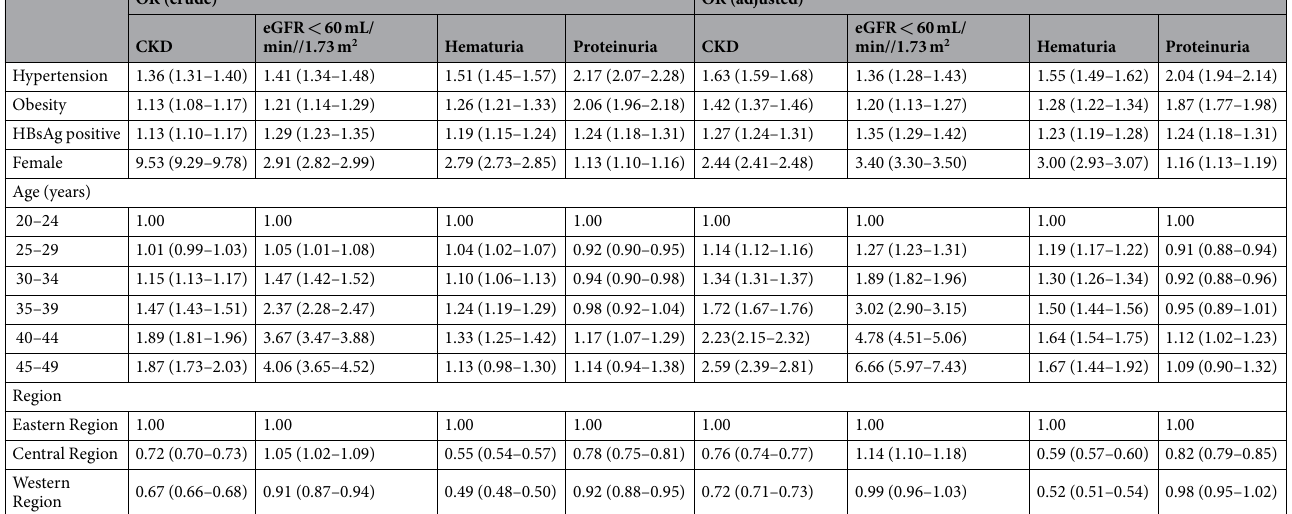
Table 5. Risk factors for CKD and indicators of married population with fertility desire in rural China. Data are represented as odds ratio (95% CI). CKD: chronic kidney disease. EGFR: estimated glomerular filtration rate (by Asian modified CKD-EPI equation). Obesity: body-mass index ≥ 28 (kg/m 2 ). HBsAg: hepatitis B virus surface antigen. CI: confidence